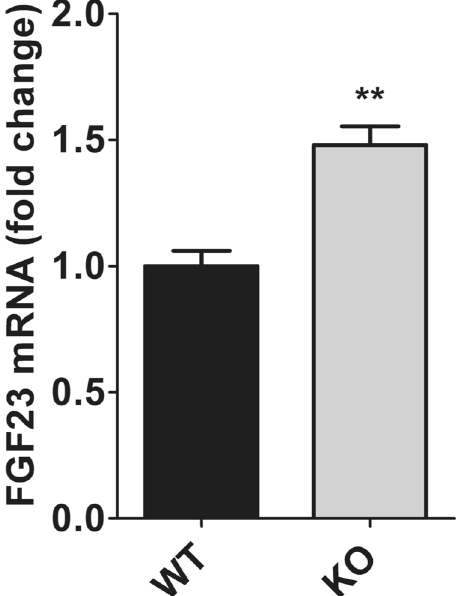
Figure 2. FGF23 mRNA levels in femora of WT and NCC KO mice. Arithmetic means ± SEM (n = 6–8) of FGF23 mRNA levels in femora obtained from WT (black bars) and NCC KO mice (grey bars) under normal diet. ** (p < 0.01) indicates significant difference from NCC WT